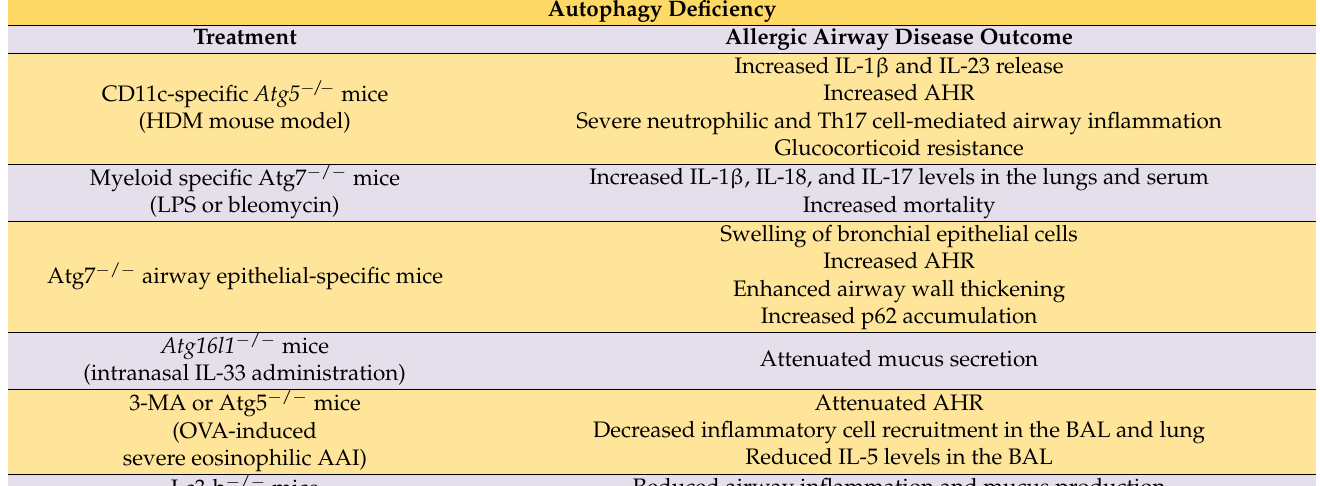
Table 2. Deficiency of autophagy and its impact on Allergic Airway Disease